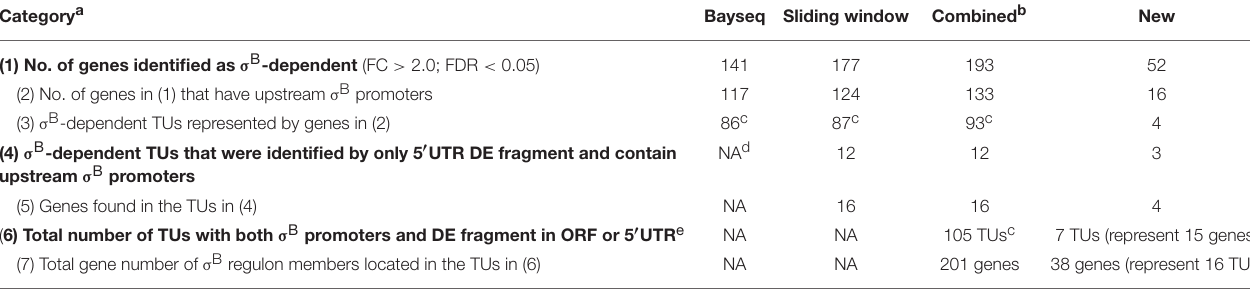
TABLE 1 | Summary of traditional Bayseq and sliding window analyses results for upregulated genes and TUs. Category